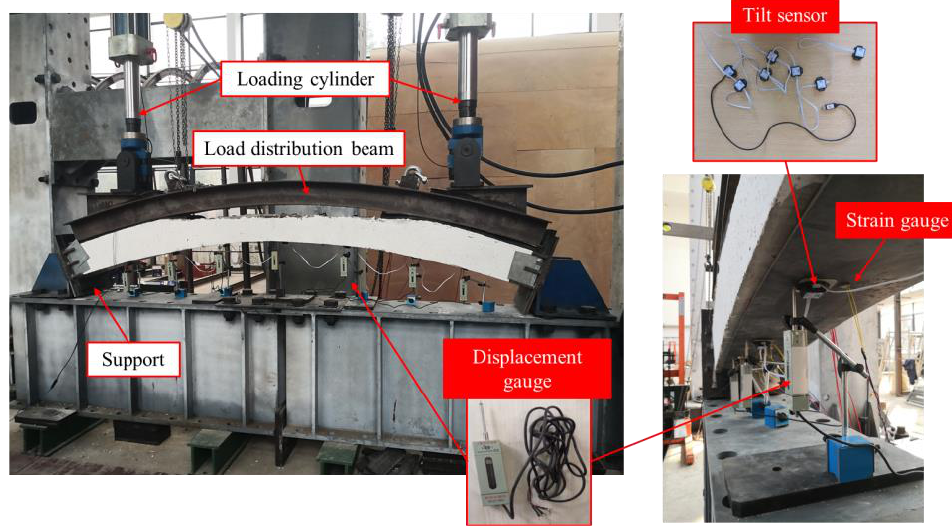
Figure 3. Loading device and measuring device.